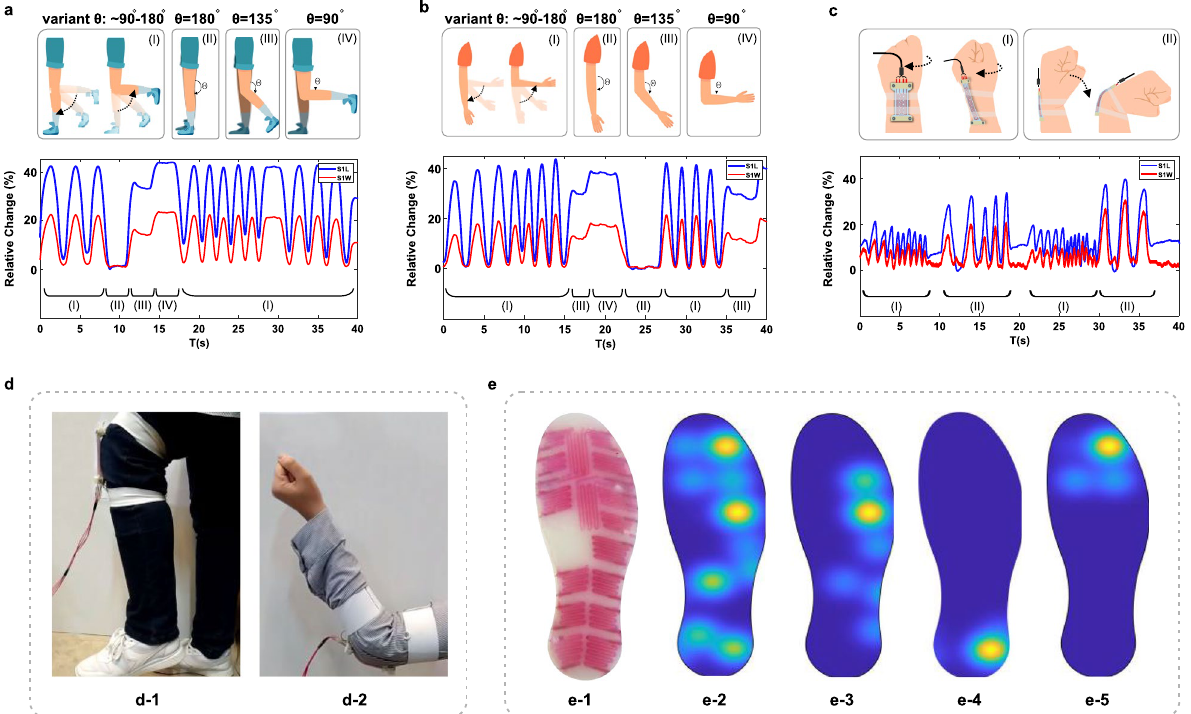
Figure 15. Practical results of using the sensor in real-world applications ( a ) Output signals of Knee movements such as (a-l) moving the knee sinusoidally with variant theta of 180 to 90, (a-ll) keeping the knee 135 90 straight, (a-ll) bending the knee at θ ◦ and also (a-lV) bending the knee till = ◦ . ( b ) Output signals of = elbow movements such as (b-l) moving the elbow sinusoidally with variant theta of 180 to 90, (b-ll)